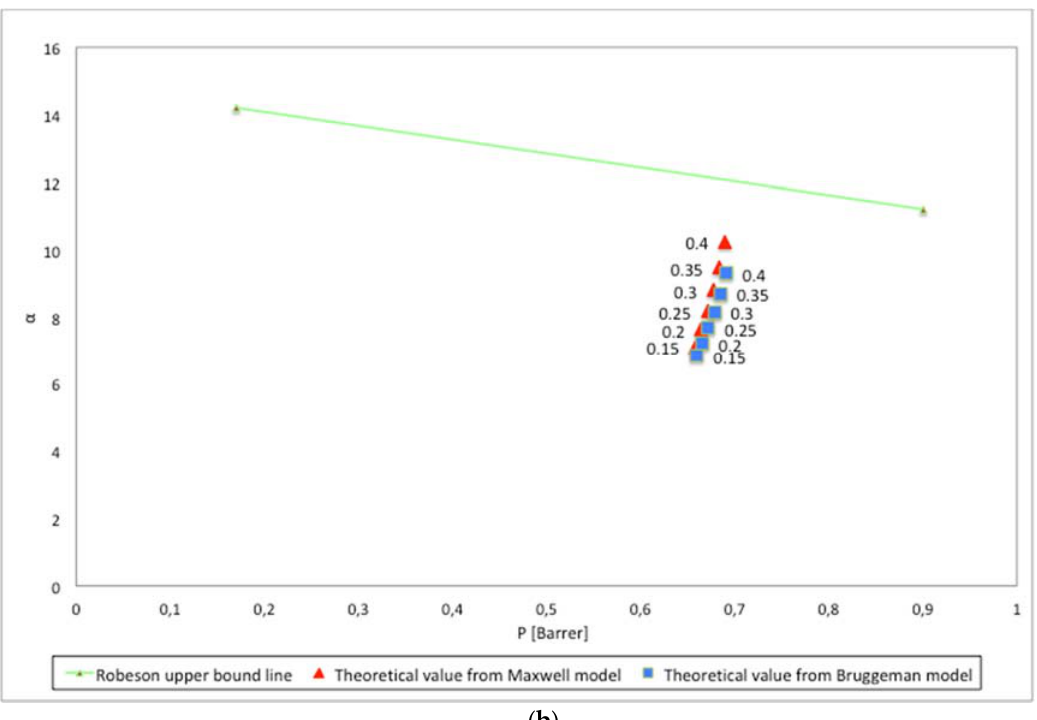
Figure 10. ( a ) Bruggeman’s model MOT window and ( b ) comparison of the theoretical MOT-predicted data for two different models: Maxwell (red points) and Bruggeman (blue points) on HBPI mixed-matrix membranes with various volume fractions of zeolite 4A particles relative to the Robeson upper bound line (green line).